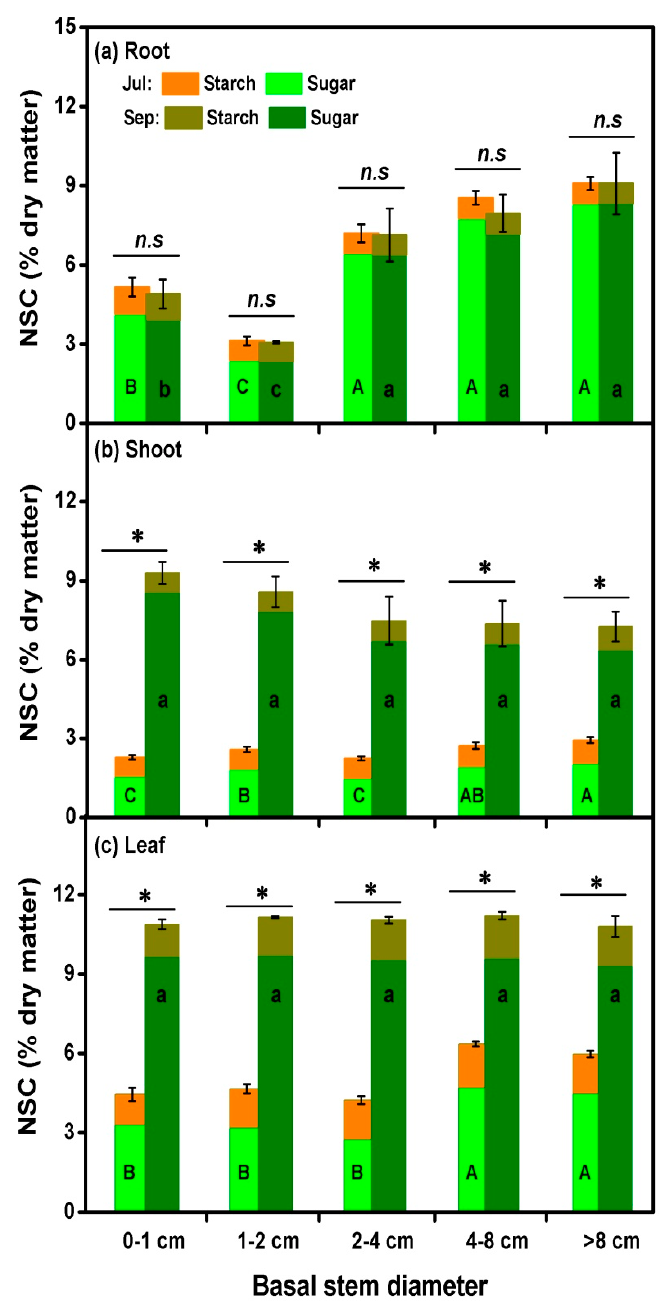
Figure 7. Mean root ( a ), shoot ( b ) and leaf ( c ) nonstructural carbohydrate (NSC) concentrations for H. ammodendron among rooting depth group as representation by di ff erent basal diameter classes. Data are mean ± 1 SE ( n = 5). The di ff erent capital letters showed significant di ff erences across basal stem diameter classes in July ( p < 0.05); the di ff erent lowercase letters showed significant di ff erences across basal stem diameter classes in September ( p < 0.05); the asterisks indicate significant di ff erences between July and September within each diameter class ( p < 0.05). Error bars is the SE of the mean ( n = 5).